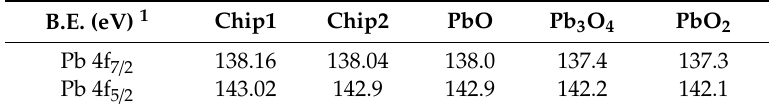
Figure 1. ( a ) The full XPS spectra (survey) of monazite. ( b ) Pb 4f XPS spectra and fitted peak for the natural monazite chip1. Table 1. Binding energies (eV) of Pb 4f for RW-1 monazite, PbO, Pb 3 O 4 , and PbO 2 .